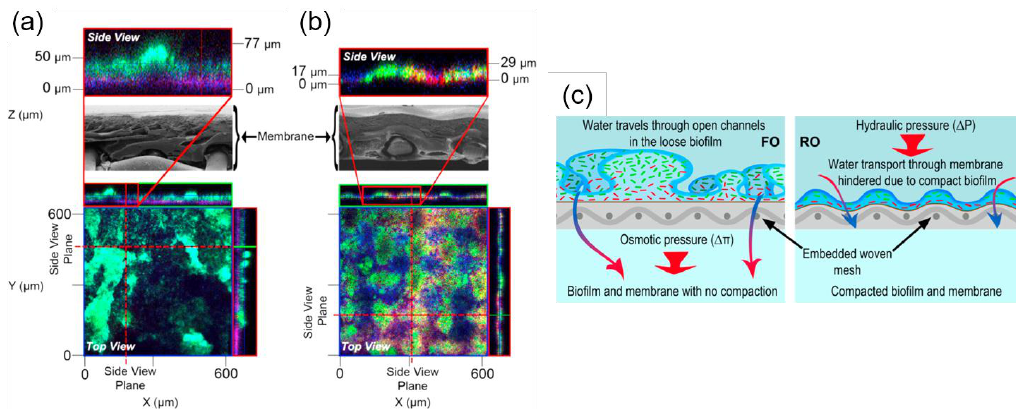
Figure 6. Confocal laser scanning microscopy (CLSM) orthogonal view of Pseudomonas aeruginosa biofilm structures developed on ( a ) FO and ( b ) RO membranes (scanning electron microscopy, SEM image) after biofouling for 24 h. The RO biofilm morphology followed the deformed membrane structure, as observed in the cross-sectional SEM images. The top insets are matching enlargements of the biofilm layer in side view; ( c ) Schematic illustration of biofouling formation in FO and RO processes, respectively. Reprinted from [87], with permission from Elsevier.